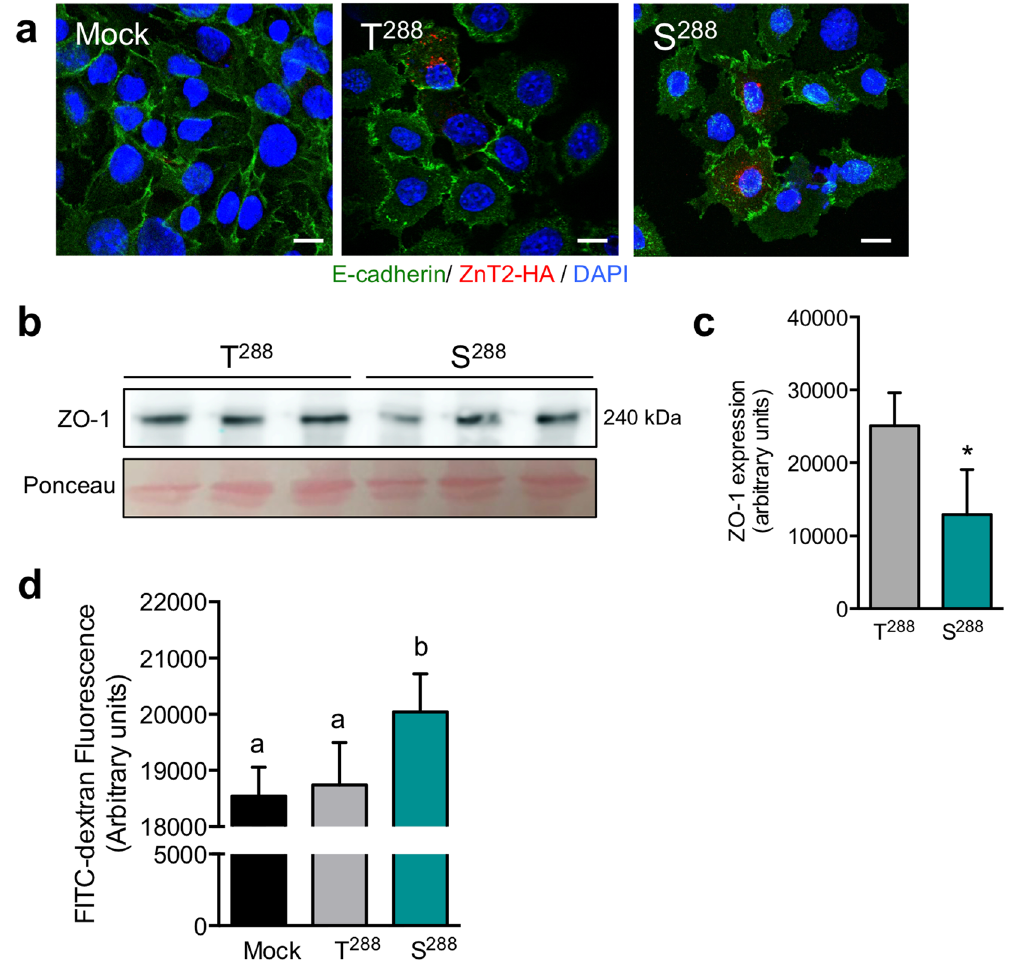
Figure 4. Barrier function is disrupted in MECs expressing the S 288 variant of ZnT2. ( a ) Representative confocal images of E-cadherin (green) and ZnT2-HA (red) in MECs transfected to express wild-type ZnT2 (T 288 ) or the ZnT2 variant (S 288 ). Nuclei were counterstained with DAPI (blue; scale bar, 10 µ m). ( b ) Representative immunoblot of zonula occludens-1 (ZO-1) in total cell lysates from MECs expressing T 288 or S 288 . Ponceau staining served as a loading control. Cropped blots are displayed and full-length blots can be found in Supplementary Fig. S5a,b. ( c ) Quantification of ZO-1 expression. Data represent mean ZO-1 signal intensity ± SD from n = 3 samples/genotype; p < 0.05 * . ( d ) Assessment of barrier function in cells expressing T 288 and S 288 . Data represent mean FITC-dextran fluorescence (arbitrary units) ± SD, from n = 3 samples/ genotype; the experiment was repeated two times. Mock represents mock-transfected MECs. Means with different letters are significantly different, p <